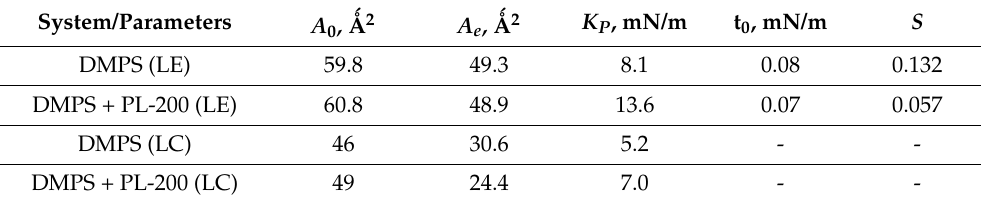
Figure 1. Volta potential ( upper panel ) and lateral pressure ( lower panel ) of DMPS monolayers at different areas of the lipid per molecule in the presence of polylysines of different lengths. The change in the Volta potential is shown for the region of continuous monolayers existing at pressures above 1 mN/m. The potential at 1 mN/m was assumed to be zero. The experimental points are sparse for convenience and the clarity of the image. The solid lines correspond to the simplest empirical description of the monolayer compression in the LE region with the parameters given in Table 1. Table 1. Fitting parameters for solid curves shown in Figure